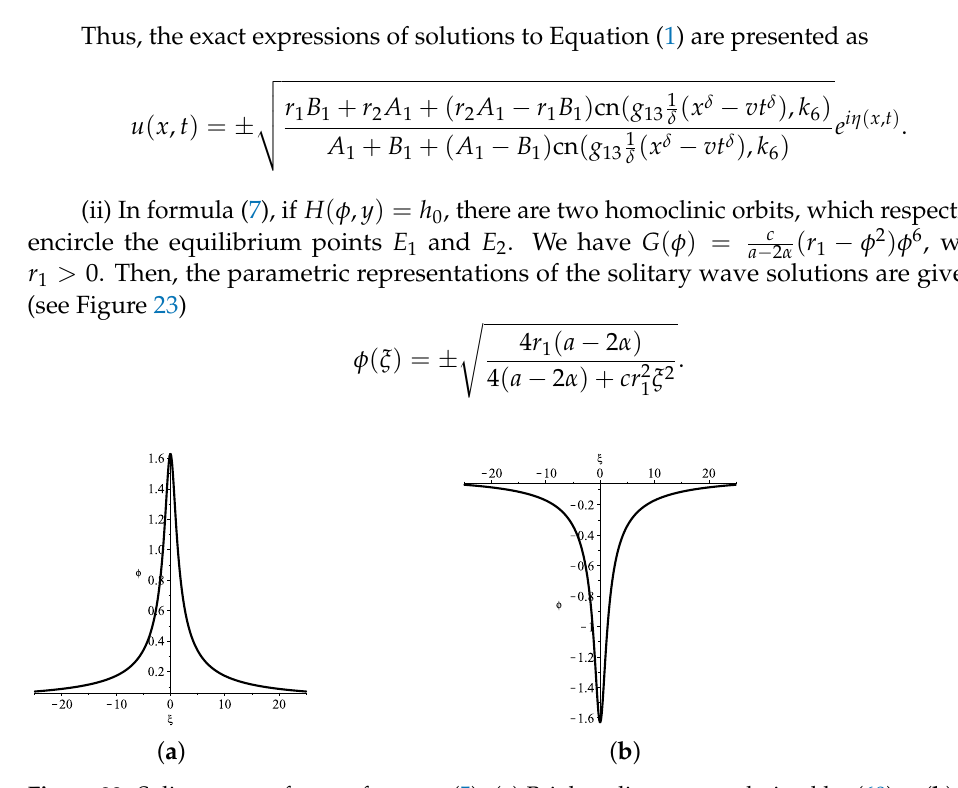
Figure 23. Solitary wave forms of system (5). ( a ) Bright solitary wave derived by (60) + . ( b ) Dark solitary wave derived by (60) −